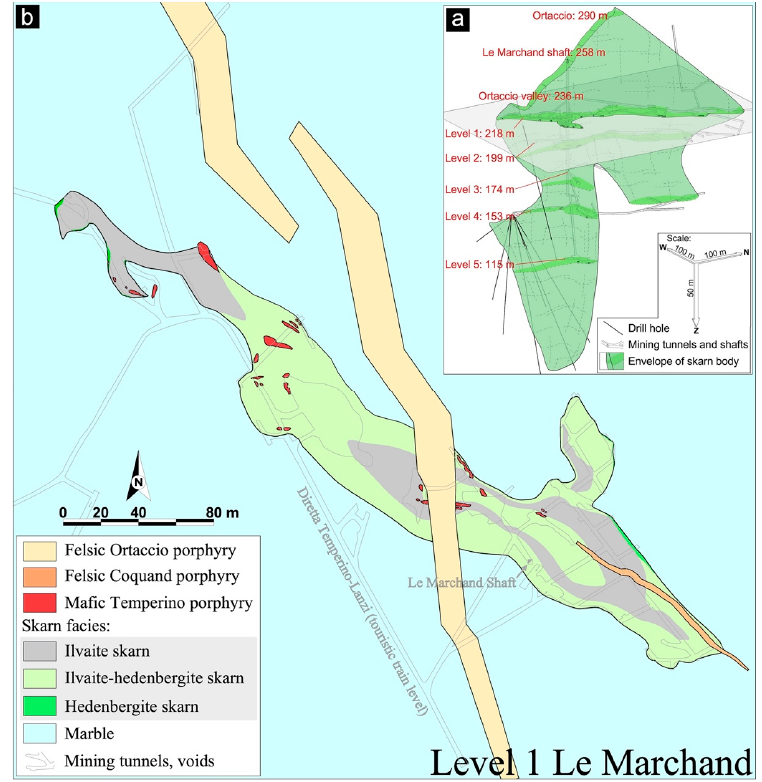
Figure 4. ( a ) Three-dimensional reconstruction of the Le Marchand skarn body (Temperino mine) based on geological survey and drill logs data. ( b ) Geological map of level 1—Le Marchand skarn body (Temperino mine) showing the distribution of the three facies and the relationships with magmatic rocks (following the methods reported in